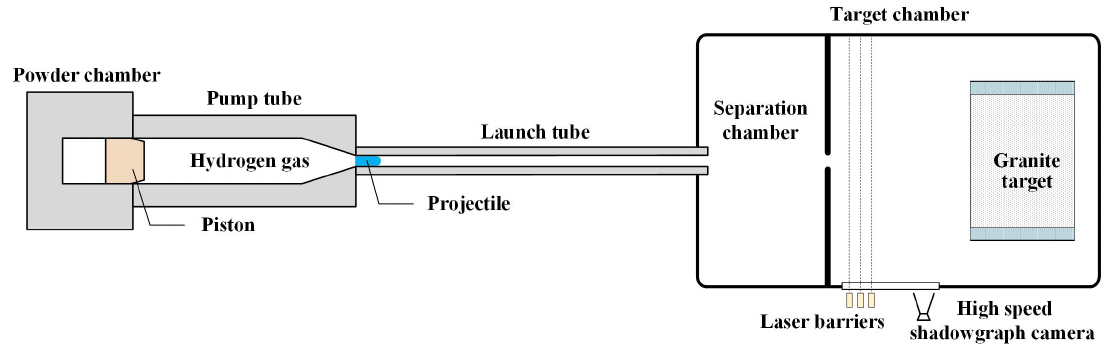
Figure 3. Schematic of a two-stage light-gas and experimental set-up.